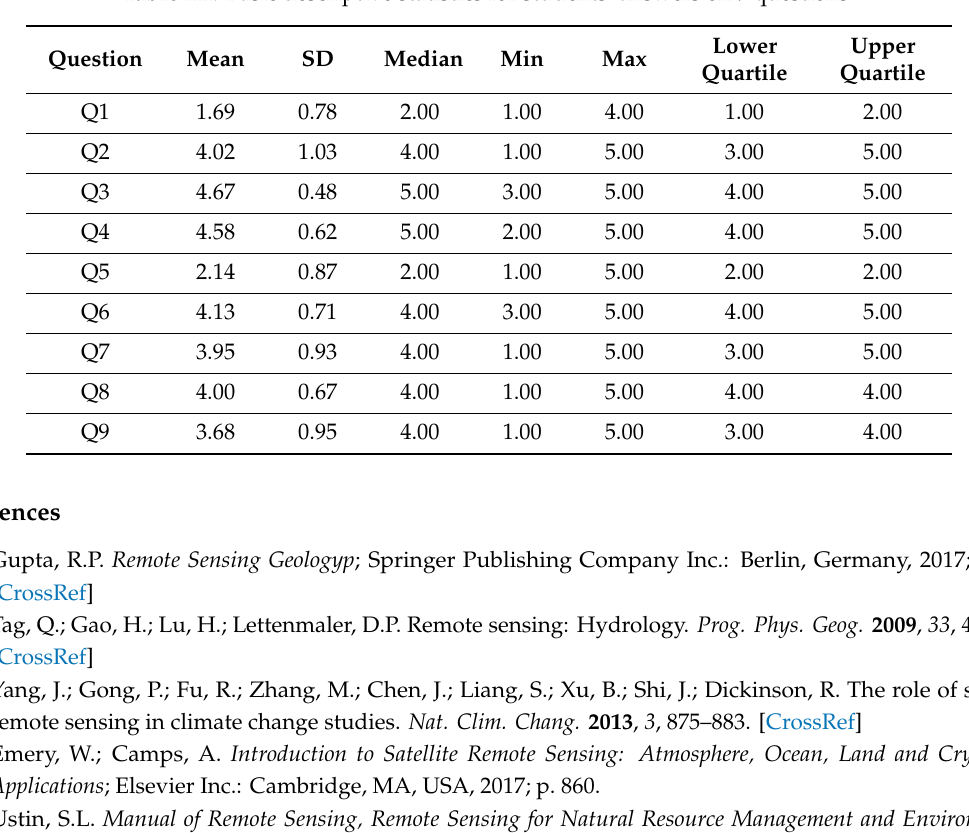
Table A1. Basic descriptive statistics for students’ answers on 9